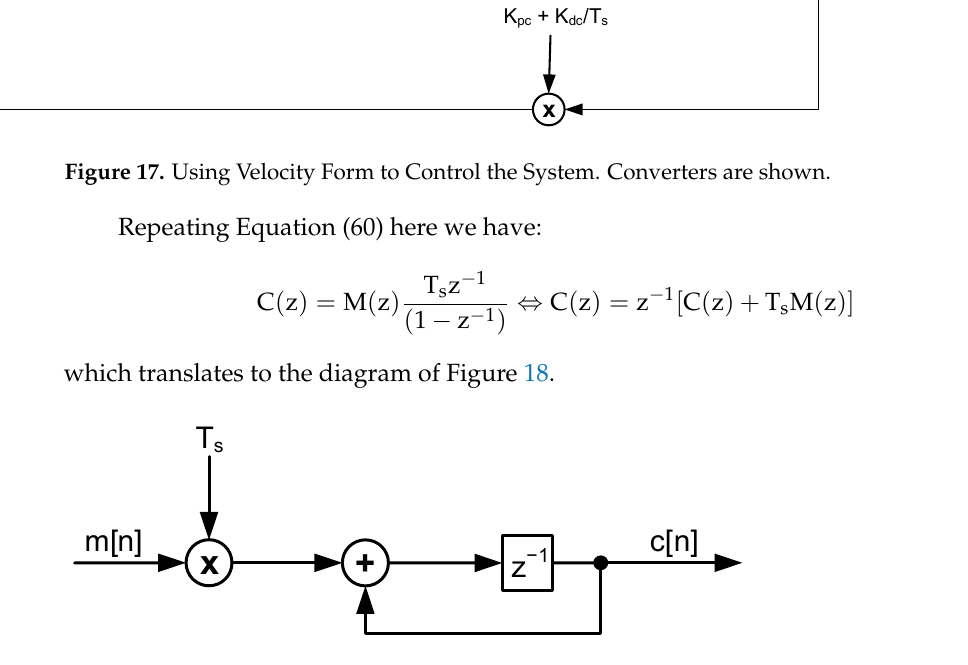
Figure 18. System with Zoh representation.